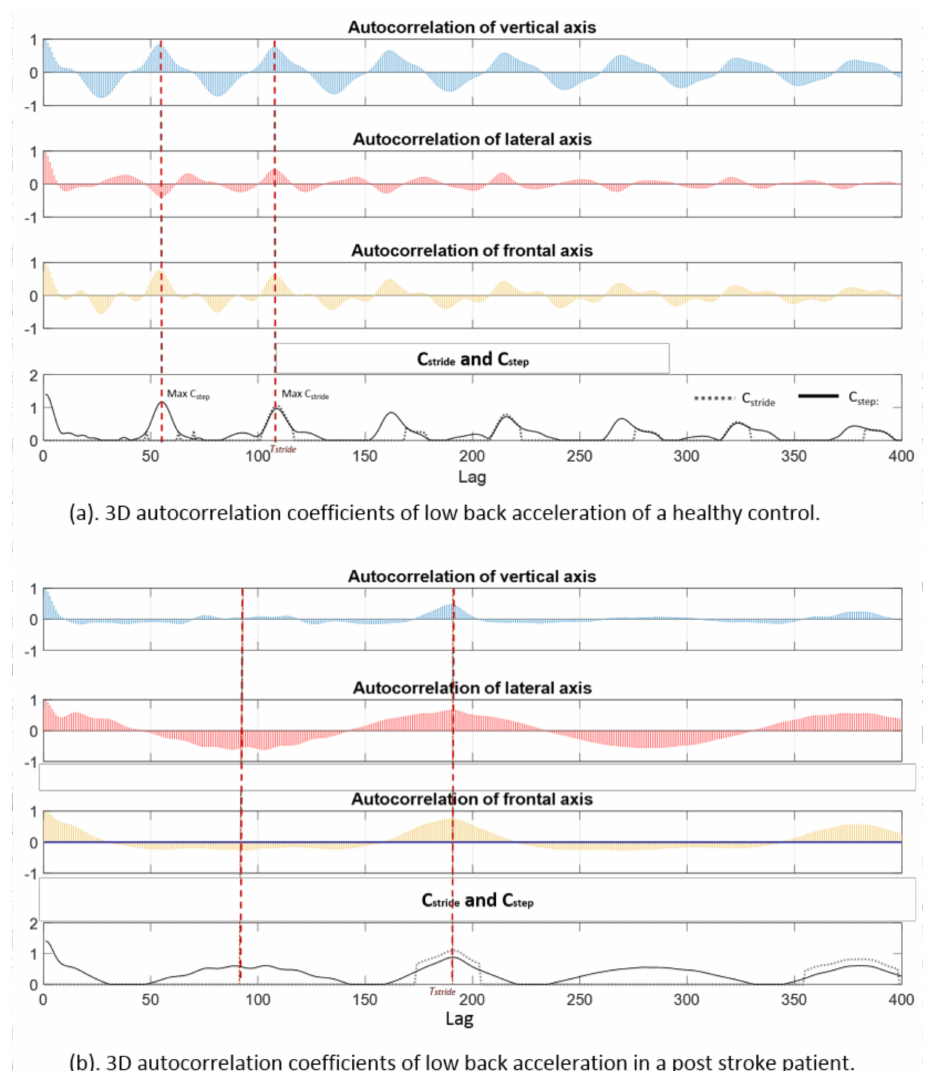
Figure 2. Autocorrelation coefficients of 3D acceleration of lower back. ( a ) Coefficients of a healthy control. ( b ) Coefficients of a post-stroke patient. Autocorrelation coefficients in vertical (blue), lateral (red) and frontal (yellow) axis are computed with increased lag from 0 to 400 samples (4 s). C stride (dotted black line) and C step (solid black line) in the bottom plot are computed as a function of time